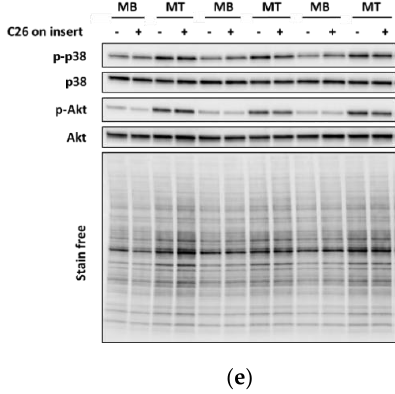
Figure 3. The 24-h coculture of C2C12 myoblasts (MB) and myotubes (MT) with C26 cells suppressed canonical and noncanonical signaling independent of the differentiation stage. ( a ) Phosphorylated Smad3 Ser423/425 and total Smad3. ( b ) Phosphorylated p38 Thr180/Tyr182 and total p38. ( c ) Phosphorylated Akt Ser473 and total Akt. In the figures, MB or MT with empty insert (-) are set as one and compared with MB or MT with C26 cells on the insert ((+), MB+C26 and MT+C26, respectively). ( d , e ) Representative blots. N = 6 – 8 per group. * = P < 0.05.